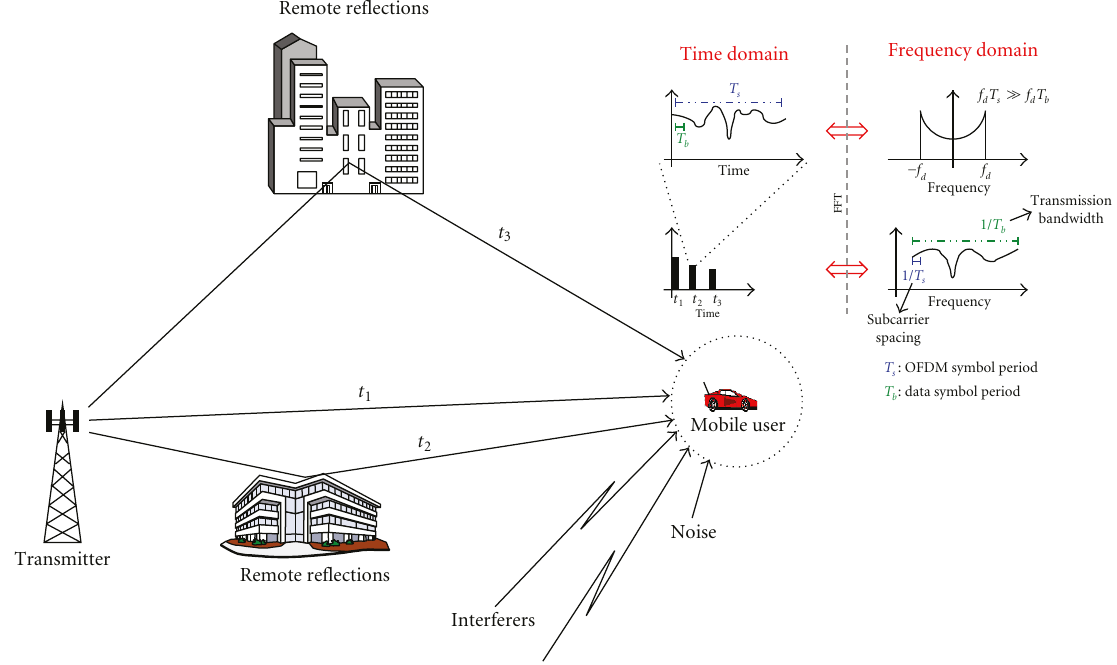
Figure 1: Illustration of some of the e ff ects of radio channel: local scatterers cause fading; remote reflectors cause multipath and time dispersion, leading to ISI; mobility of user or scatterers causes time varying channel, leading to frequency dispersion (Doppler spread); reuse of frequencies, adjacent carriers, and so forth, cause